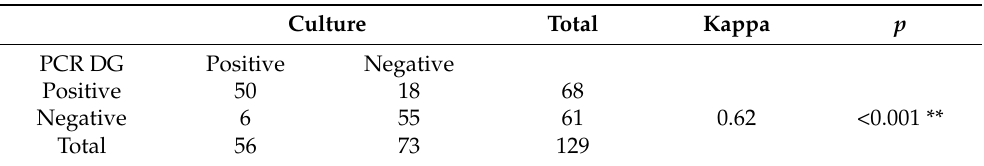
Table 2. Evaluation of complete multiplex real time PCR DermaGenius ® (DG PCR) versus the reference test (fungal